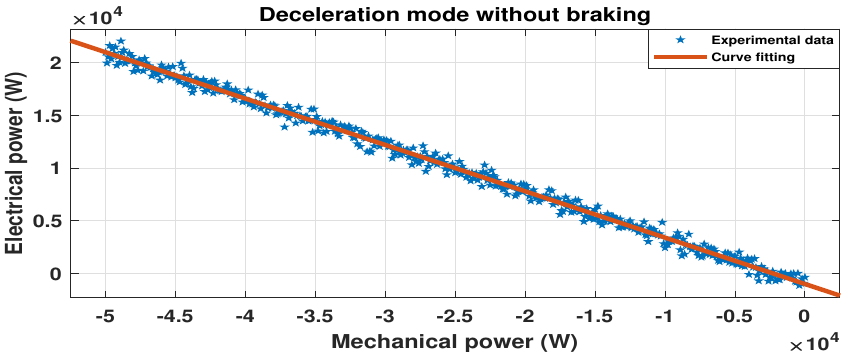
Figure 13. Battery power as a function of mechanical power in deceleration mode without